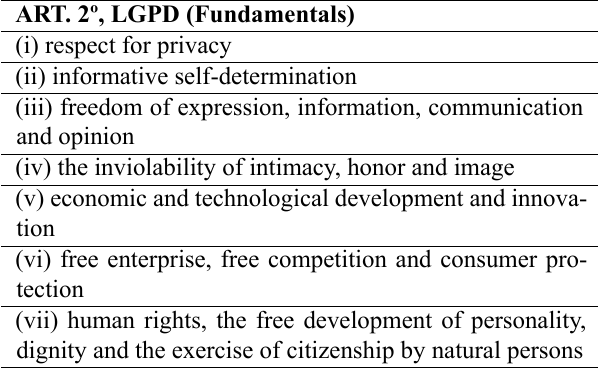
Table 2. Fundamentals of personal data protection provided by LGPD.